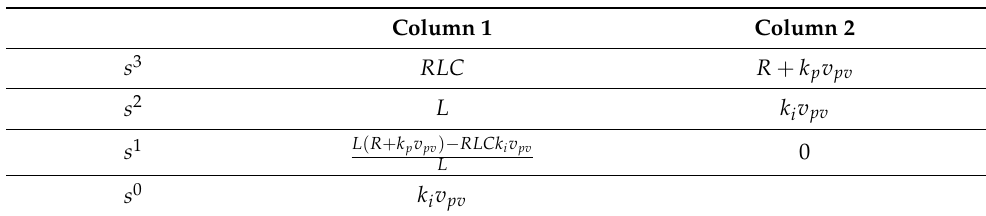
Column 1 Column 2